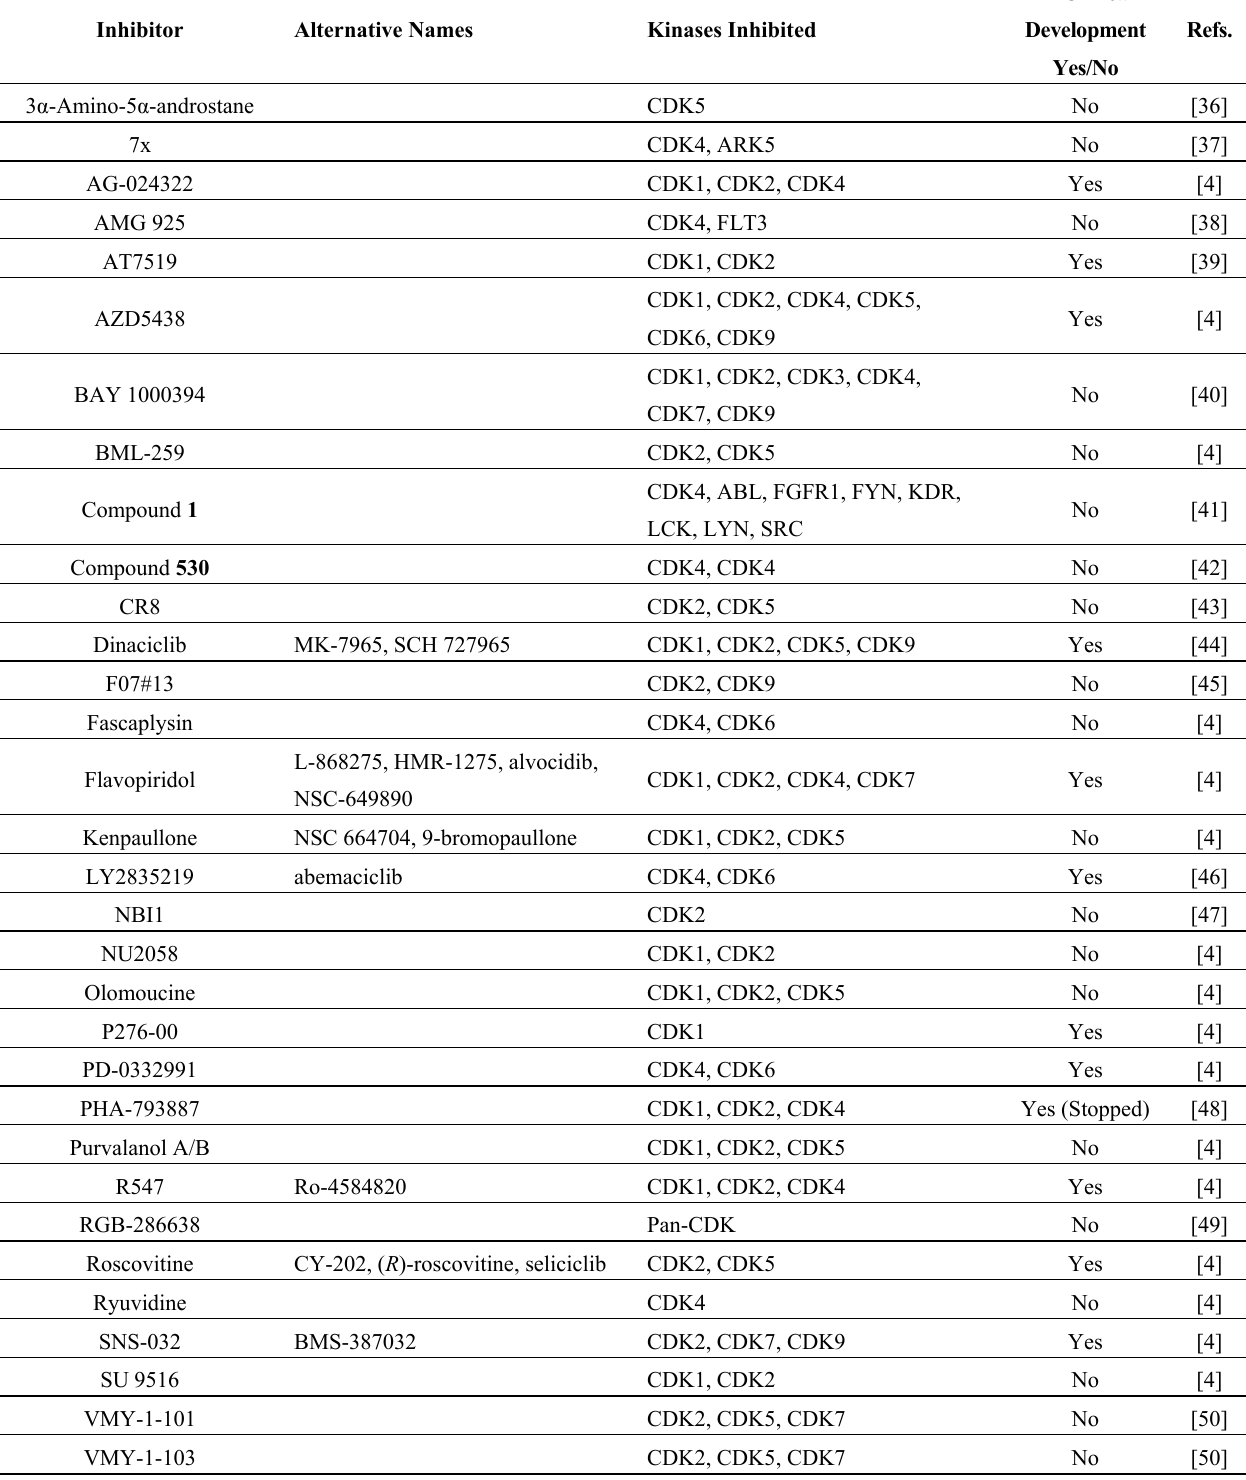
Table 1. List of CDK